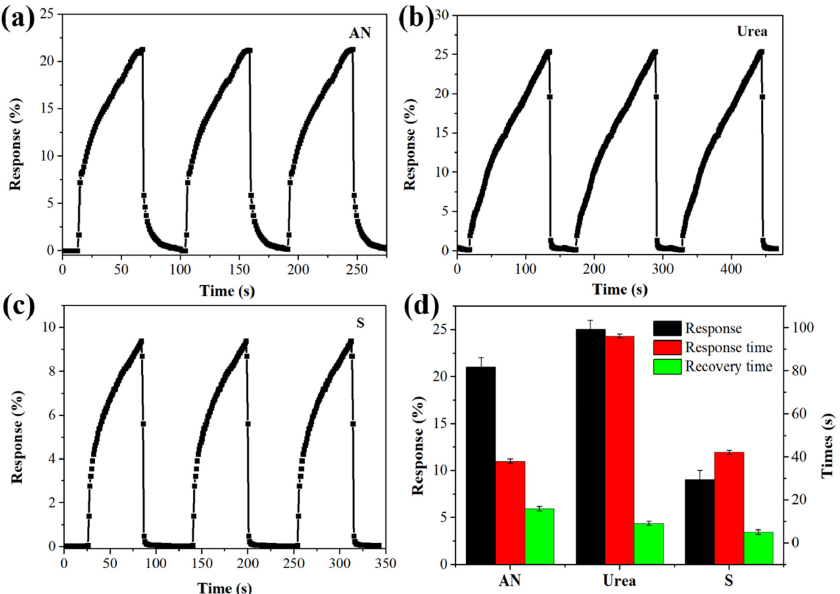
Figure 12. Time-dependent response of the TiO 2 –FTO–HJ in room-temperature to saturated AN ( a ), urea ( b ) and S ( c ) vapor and corresponding response time and recovery time ( d